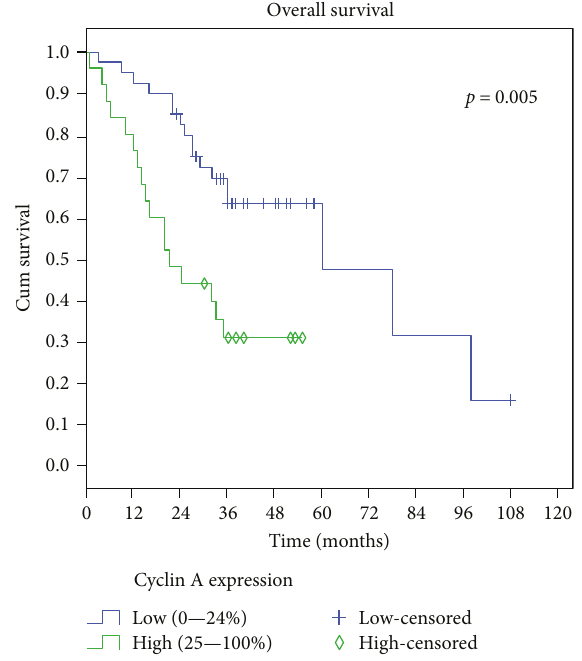
Figure 2: Univariate Kaplan-Meier analysis of overall survival in patients with OSCC. Patients with tumours with high expression of cyclin A2 presented a lower survival rate than patients with low expression of cyclin